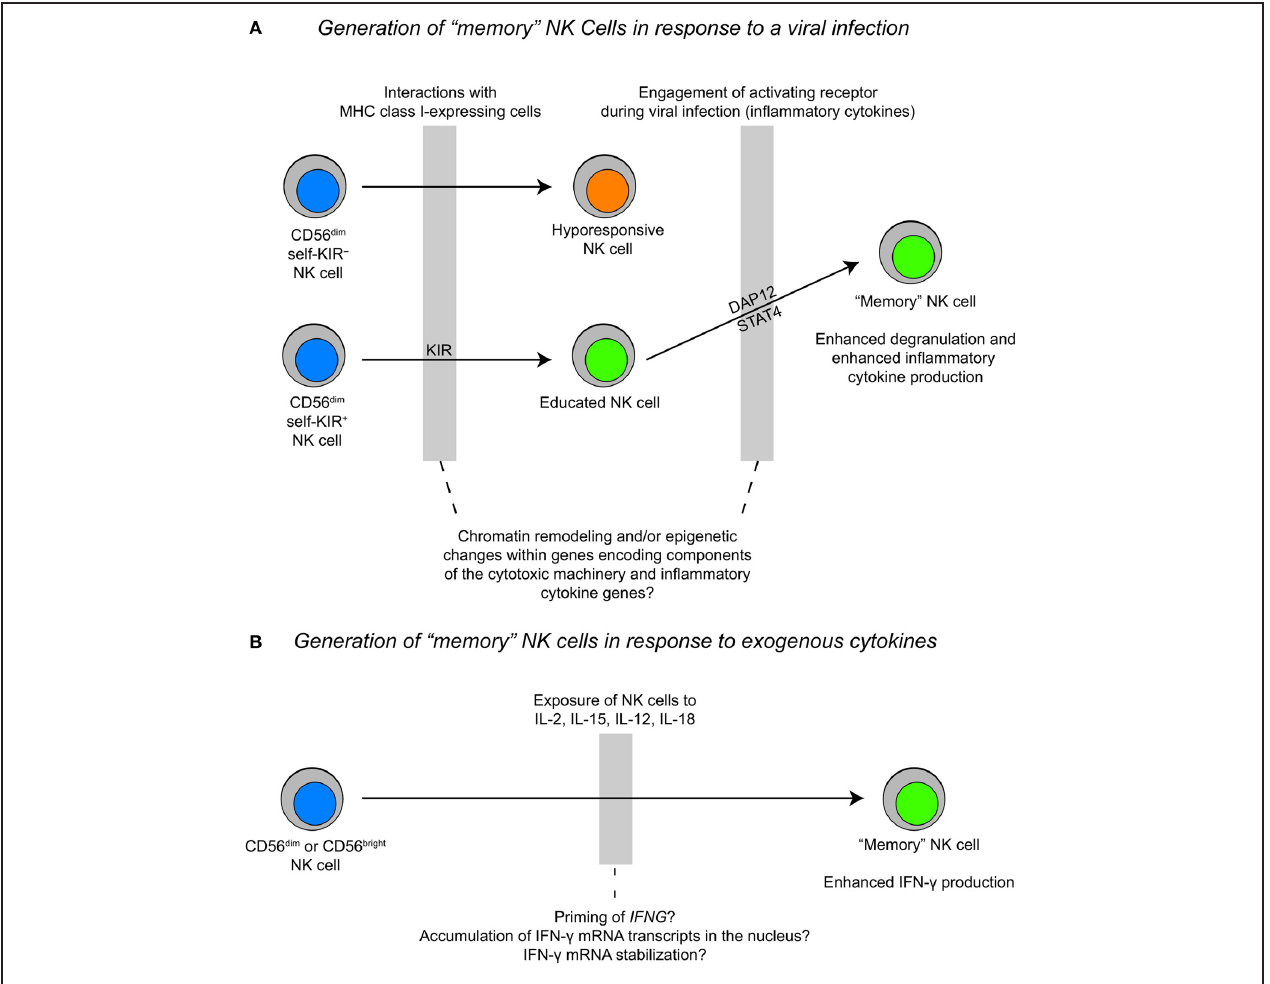
FIGURE 3 | Proposed models for the generation of “memory” NK cells during a viral infection vs. cytokine priming. (A) The generation of “memory” NK cells during a viral infection likely happens within the context of NK cell education, where an “educated” NK cell expands during a viral infection and exhibits rapid cytotoxicity and inflammatory cytokine production